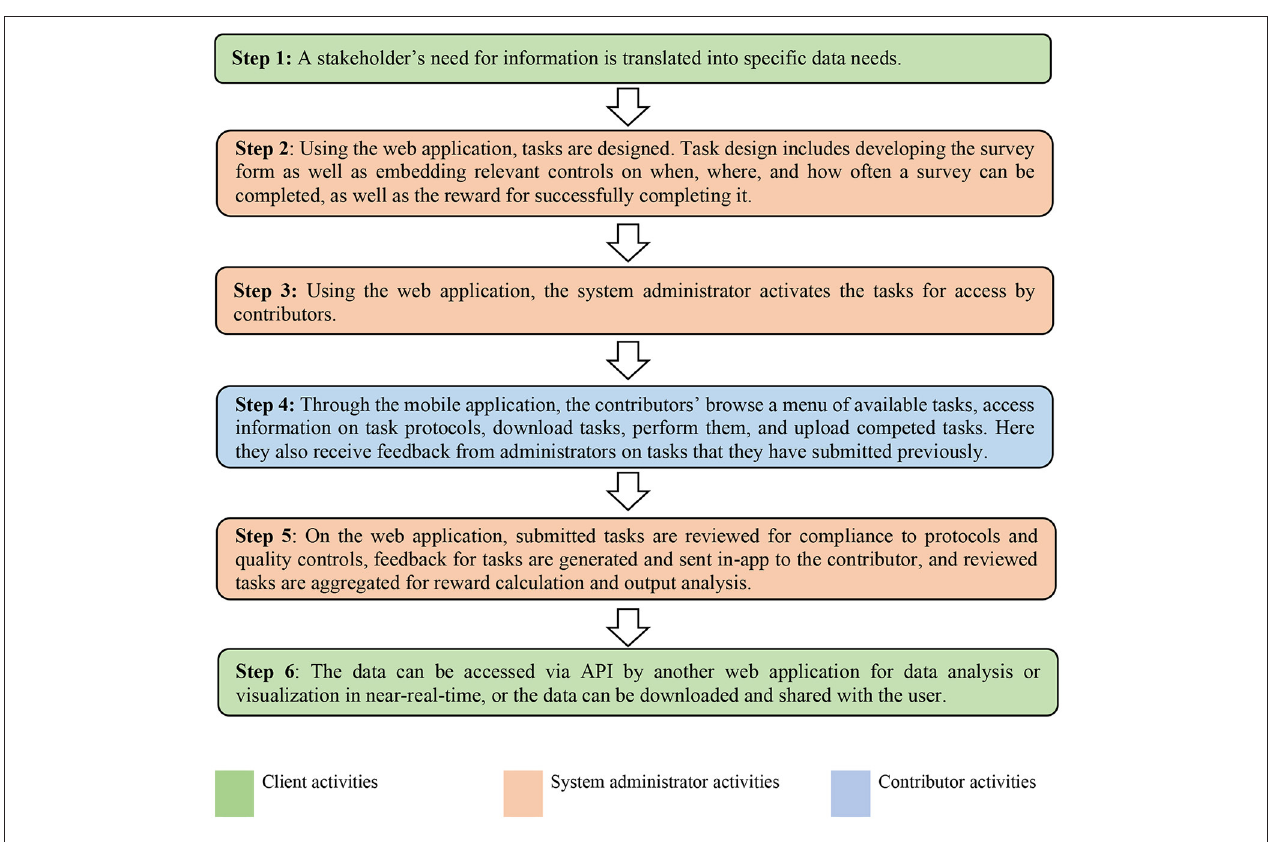
FIGURE 1 | The design flow of the KAZNET platform